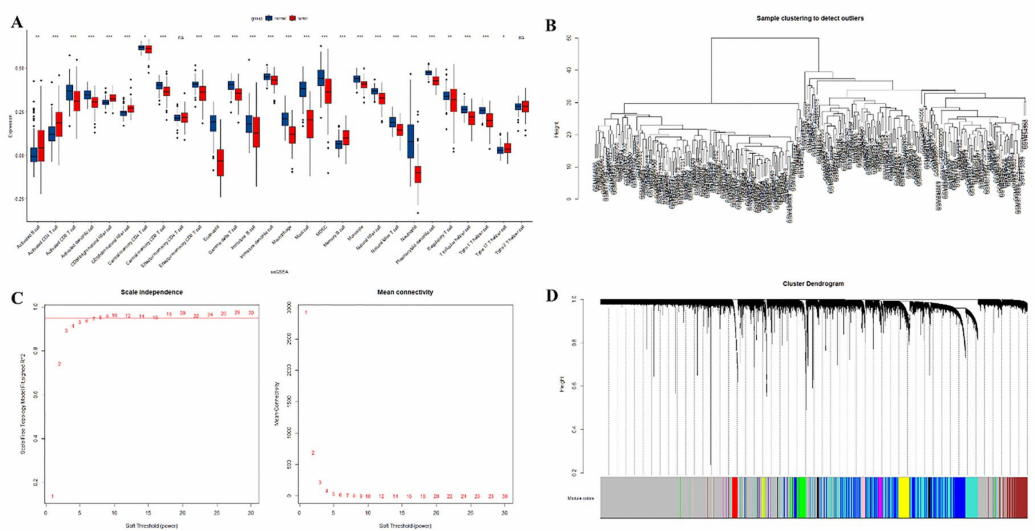
Figure 3. ( A ): Prediction of the distribution of immune infiltrating cells between lung cancer tissue and adjacent normal lung tissue by ssGSEA. The x -axis shows the different immune cells, and the y -axis shows the scores of the ssGSEA. * indicates p < 0.05, ** indicates p < 0.01, *** indicates p < 0.001, and **** indicates p < 0.0001. Differences were considered statistically significant at p < 0.05, and ns indicates that the differences are not statistically significant. ( B ): sample clustering; ( C ): selection of optimal soft thresholds for WGCNA; ( D ): tree diagram of the WGCNA module.